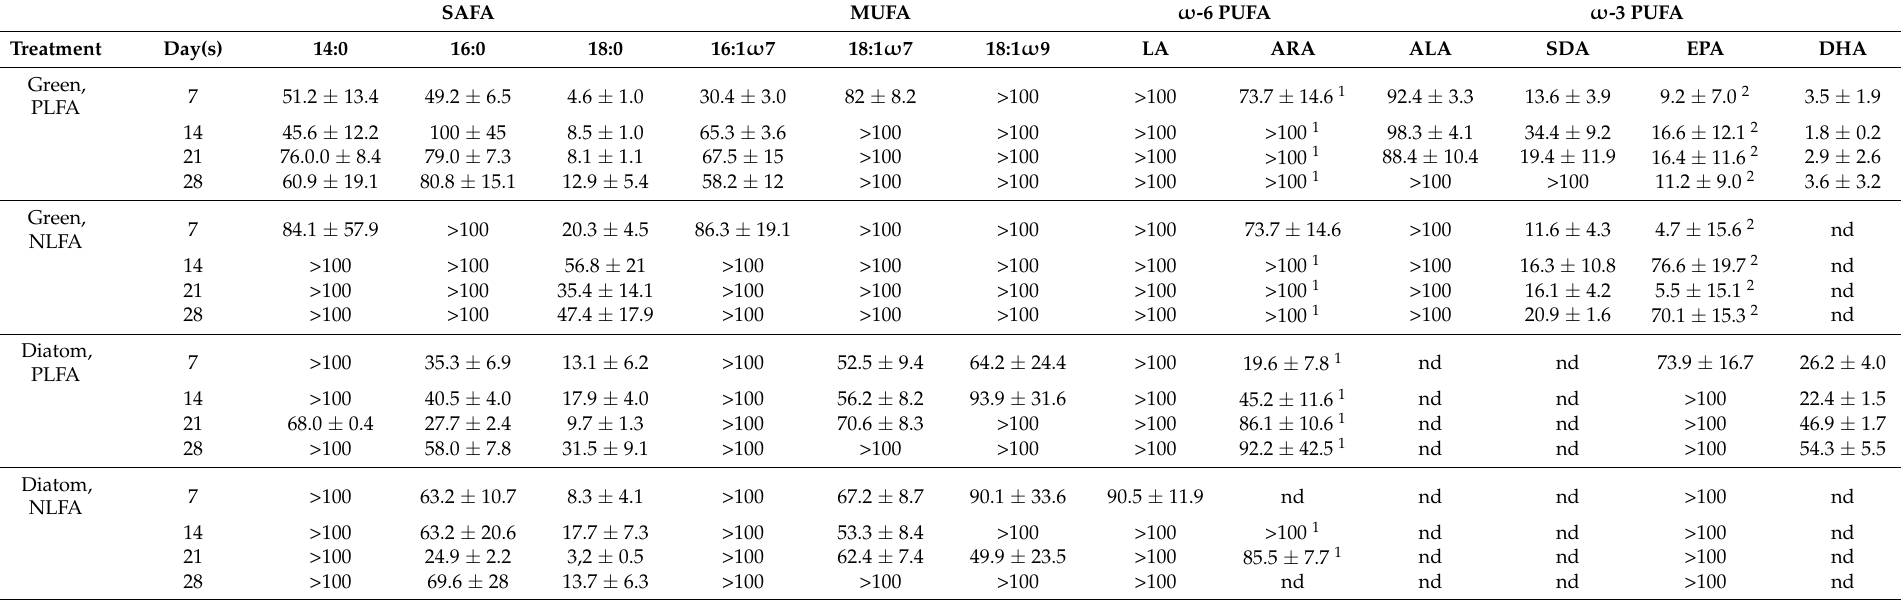
Table 3. The contribution ( ± standard error) of dietary (green algae or diatom) FAs of amphipods ( P. quadrispinosa ) PLFAs and NLFAs after 7, 14, 21 and 28 days based on calculations in IsoError [55]. In cases where the contribution exceeds 100%, the amphipod δ 13 C value of FA was higher than the diet. SAFA MUFA ω -6 PUFA ω -3 PUFA Treatment